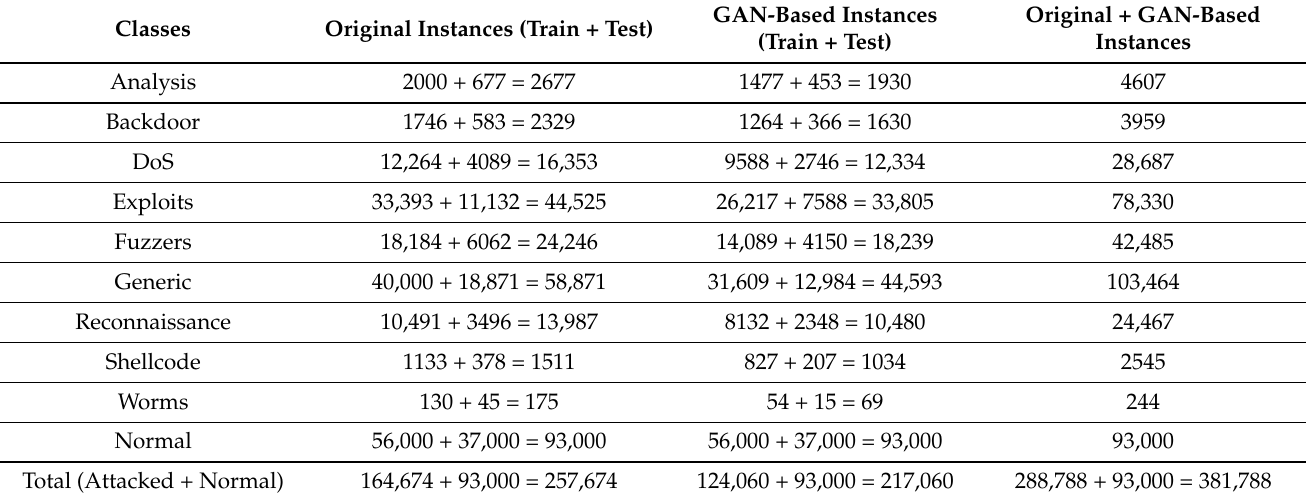
Table 2. Proposed-framework-based original and generated dataset instances against each